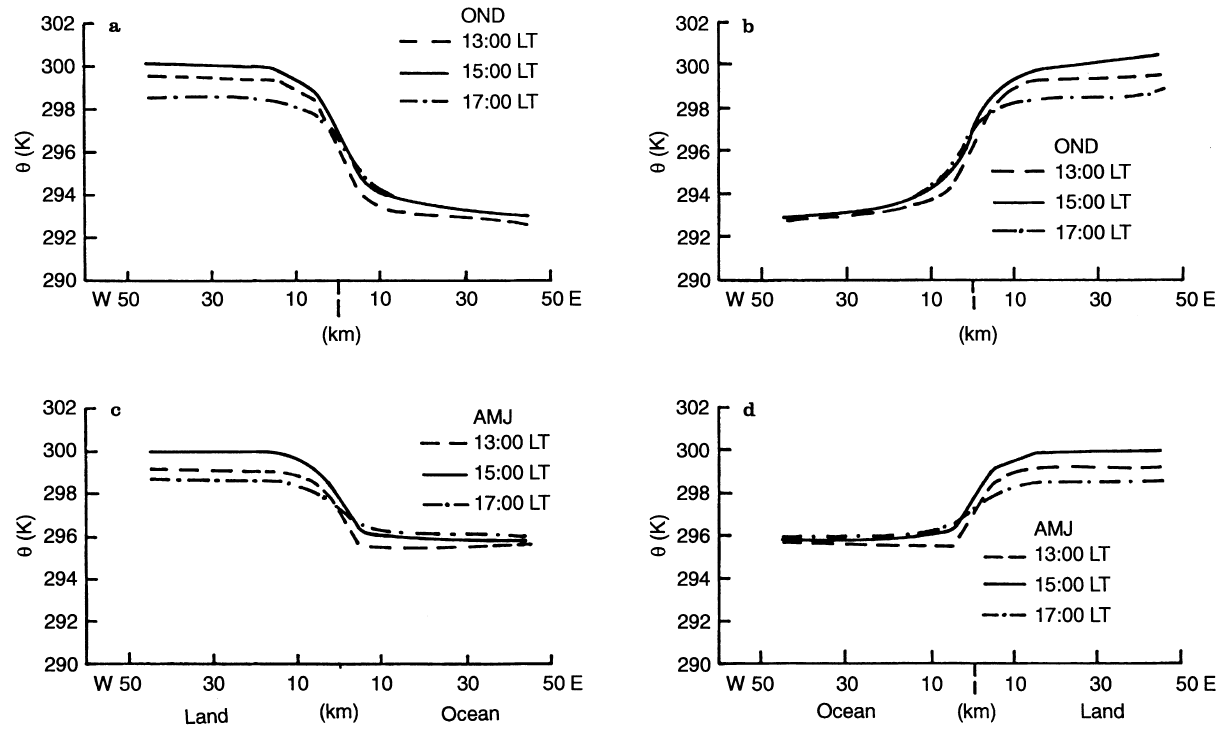
Fig. 10a–d. Horizontal variation of the simulated potential tempera- ture (at level of 990 hPa) for three time stages: a EW variation along a line parallel to AB (Fig. 1) situated 5 km northward from the EW